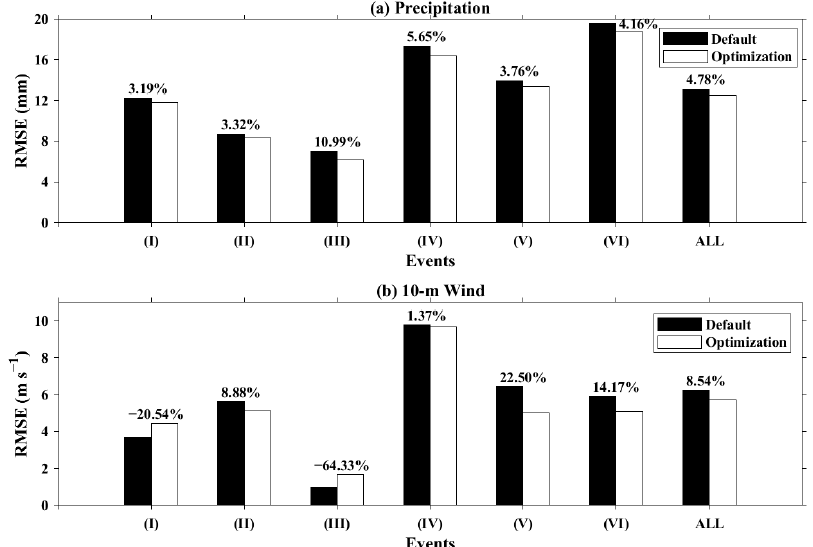
Figure 14. Comparisons of the simulation errors of six validated typhoon events (I)–(VI) using the WRF model with default and optimal parameters for: ( a ) 6-hourly precipitation ( b ) 6-hourly 10-m wind.